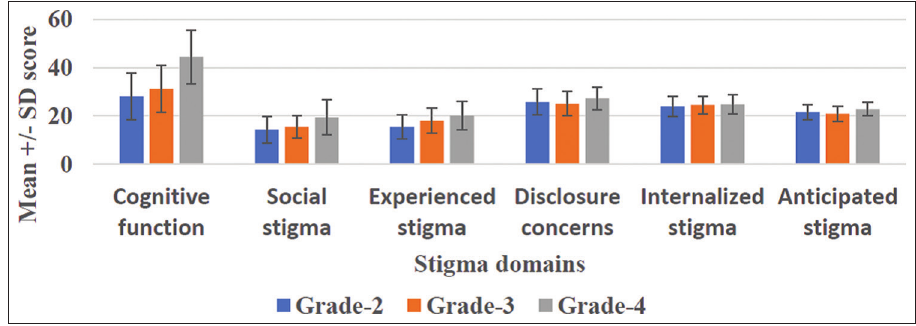
FIGURE 1. Comparison of stigma mean scores by lymphatic filariasis grades and